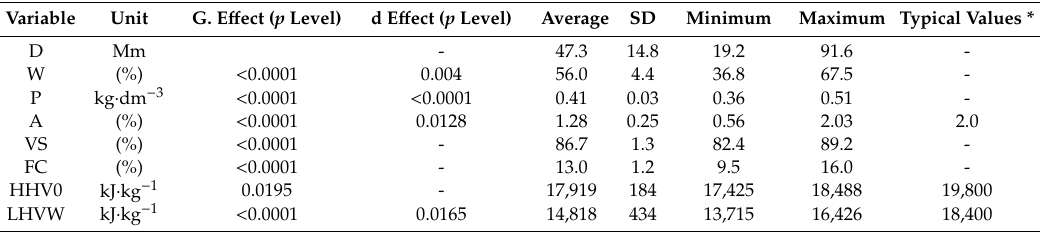
d = basal diameter, W = green moisture content, ρ = basic density, A = ash, vs. = volatile matter, FC = fixed carbon, HHV 0 = higher heating value, LHV w = lower heating value. * Typical values for poplar according to [4] standard.